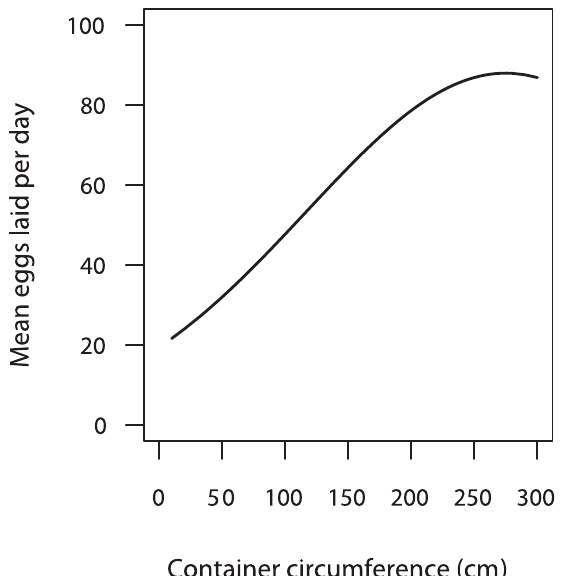
Figure 2. Relationship between eggs laid per day and container circumference. Based on the regression equation y = exp [2.964 + (0.011*X) + ( 2 0.00002*X 2 )]. Graph begins at X=10 cm, the smallest container circumference observed. time in all container treatments, peaking in weeks 4 and 5, and again in week 11. (ANOVA F = 41.55; df= 6, 30; p , 0.001) (Figure 5a) and